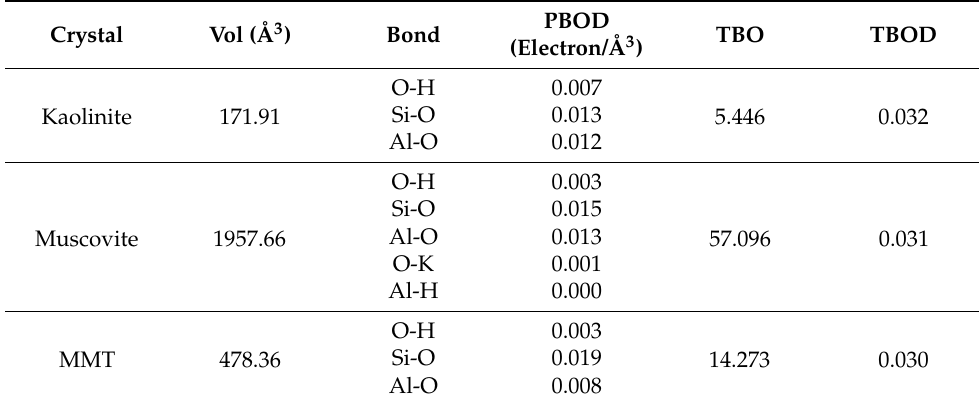
Table 2. TBOD and PBOD for kaolinite, muscovite, and